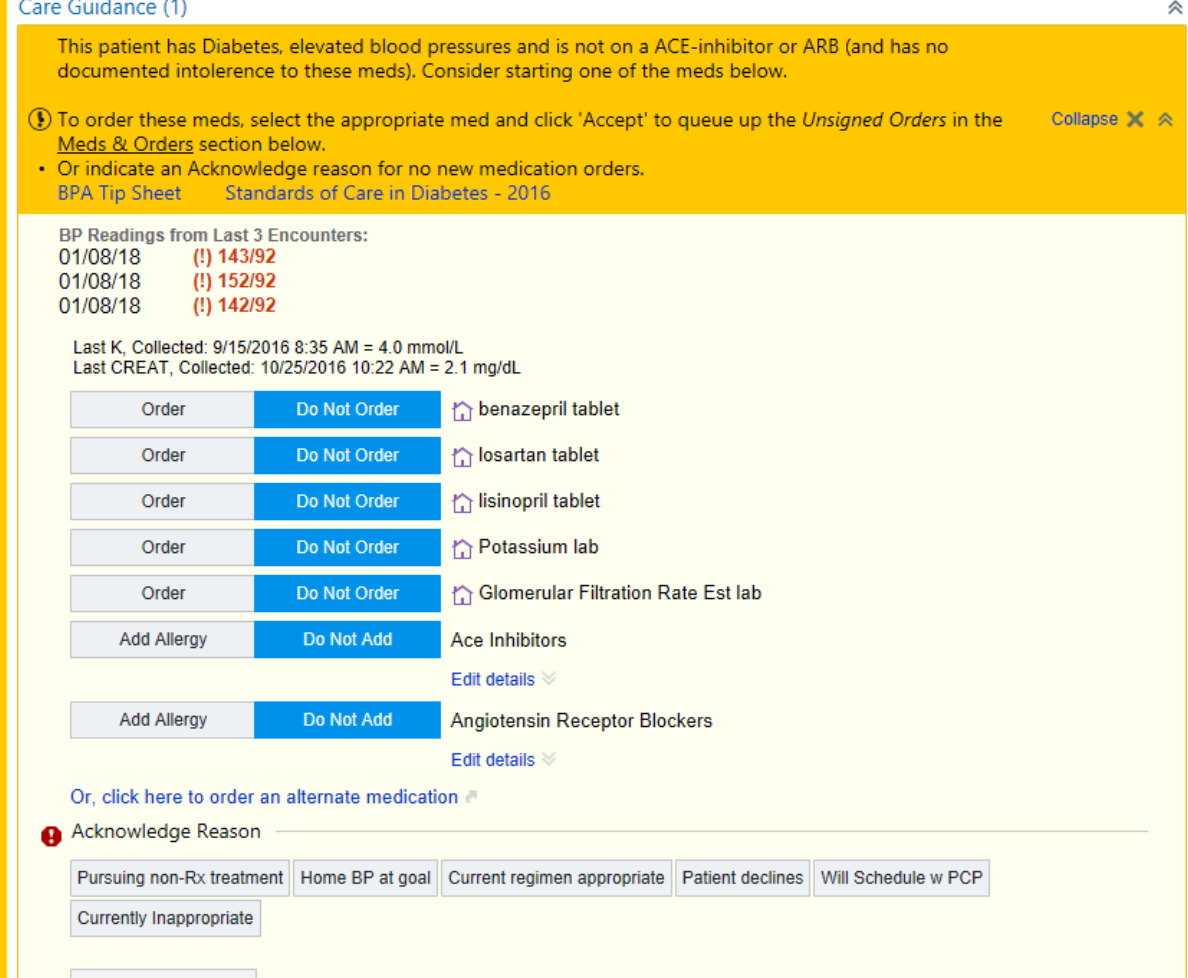
Figure 2. The Best Practice Advisory prompts primary care providers to order an angiotensin-converting enzyme inhibitor or angiotensin-receptor blocker or to dismiss the alert by clicking an acknowledge reason. Home BP at goal: Home blood pressure at goal; Pursuing non-Rx treatment: pursuing nonprescription treatment; Will Schedule w PCP: will schedule with primary care